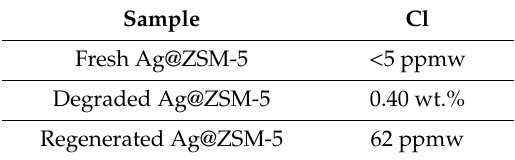
Table 2. Elemental analyses of chloride in fresh, degraded, and regenerated Ag@ZSM-5 samples.